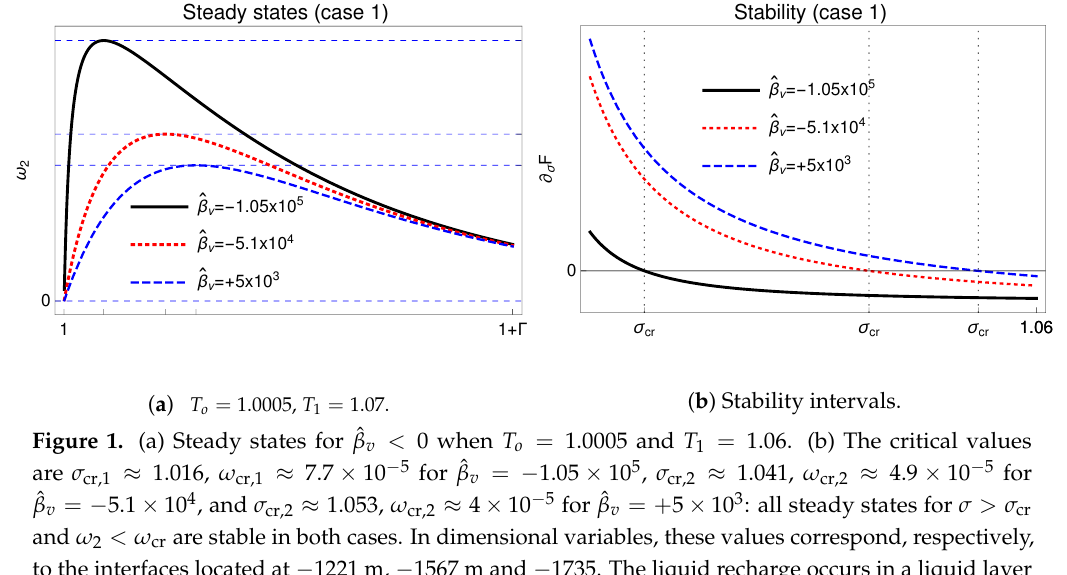
Figure 1. (a) Steady states for ˆ β v < 0 when T o = 1.0005 and T 1 = 1.06. (b) The critical values are σ cr,1 ≈ 1.016, ω cr,1 ≈ 7.7 × 10 − 5 for ˆ β v = − 1.05 × 10 5 , σ cr,2 ≈ 1.041, ω cr,2 ≈ 4.9 × 10 − 5 for ˆ β 4 , and σ ≈ 1.053, ω ≈ 4 × 10 − 5 for ˆ β v = + 5 × 10 3 : all steady states for σ > σ cr v = − 5.1 × 10 cr,2 cr,2